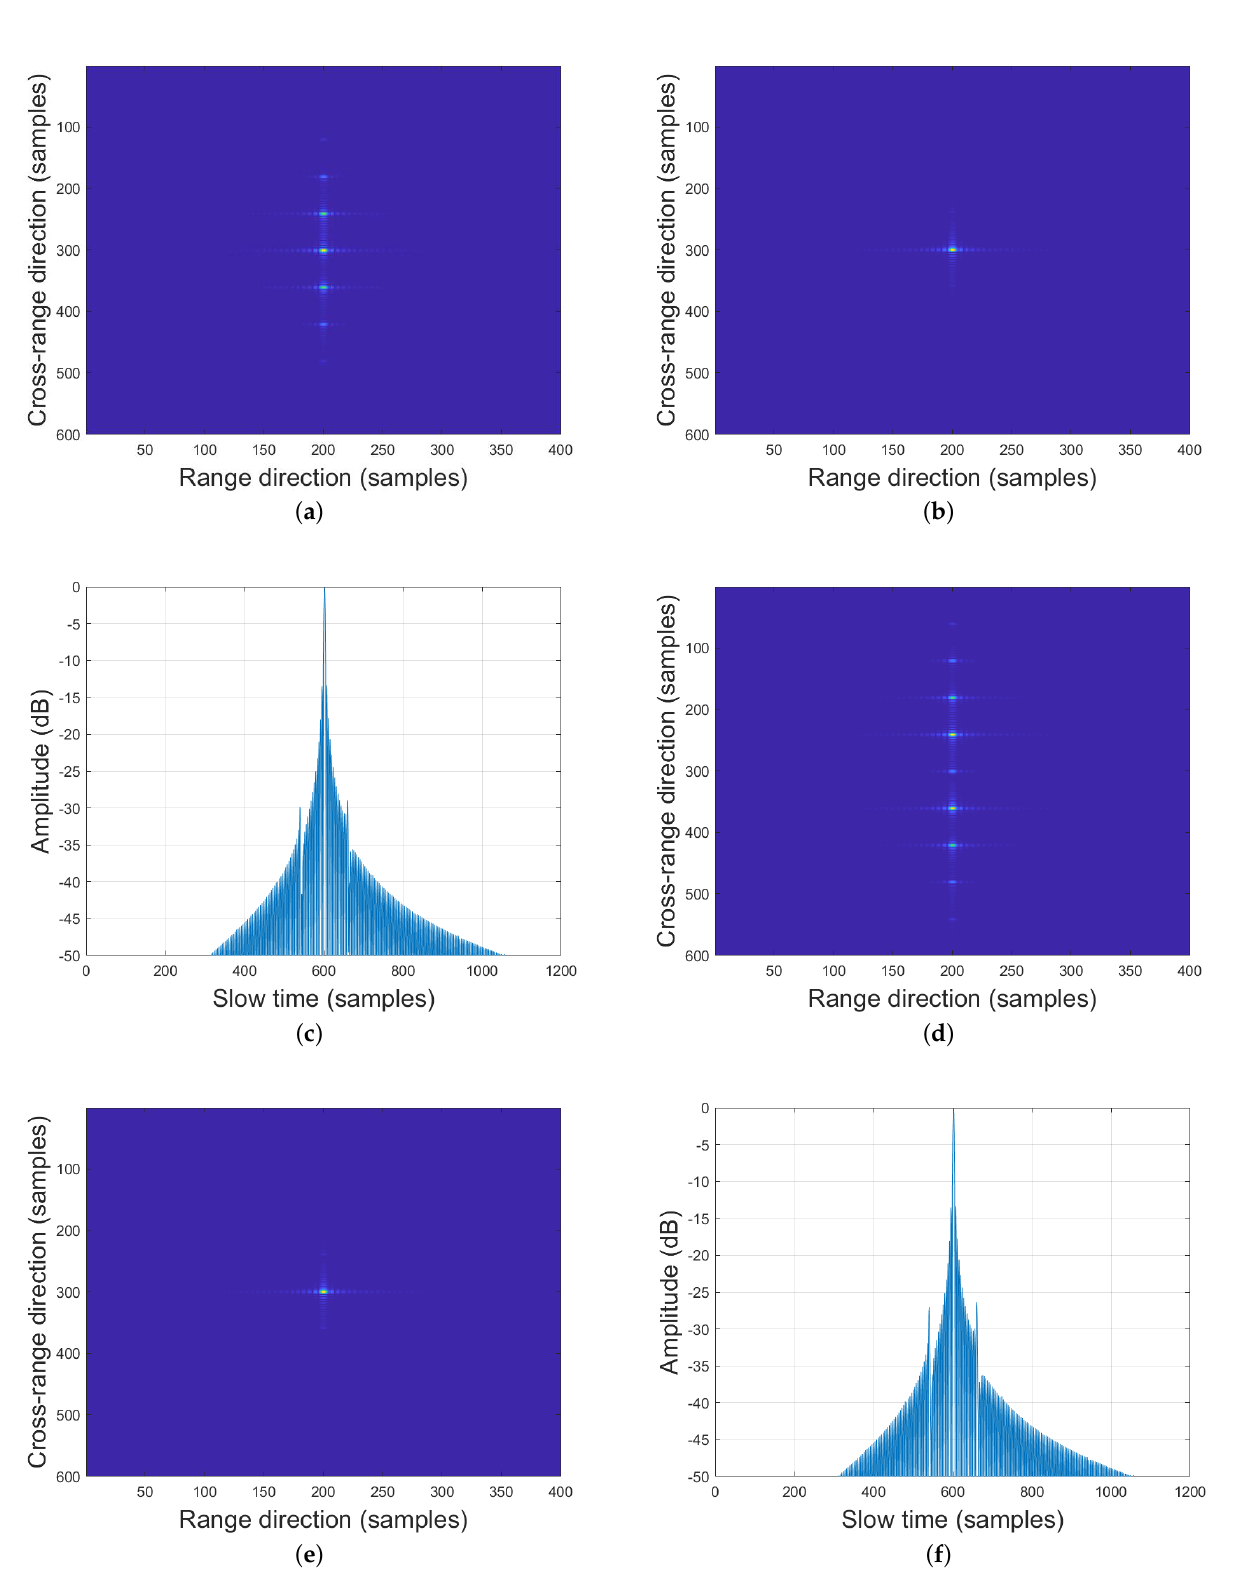
Figure 10. Compensation results. ( a – c ) show the simulation of target 1, the image result before and after MOCO, and the cross-range result after MOCO. ( d – f ) show the simulation results of target